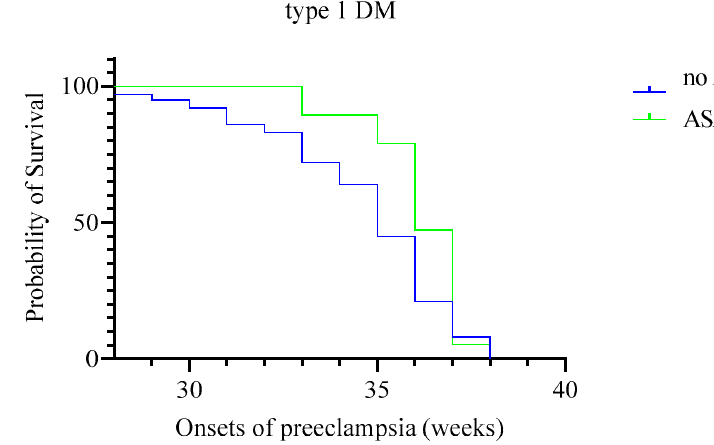
Figure 3. Onsets of preeclampsia in patients with type 1 DM.